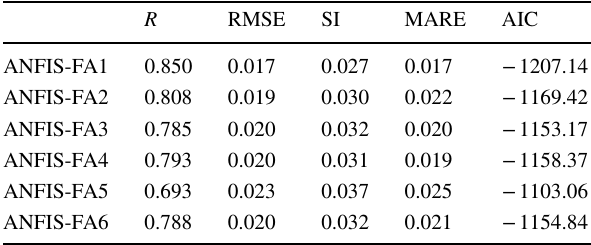
Table 4 Results of different statistical indices for six ANFIS-FA